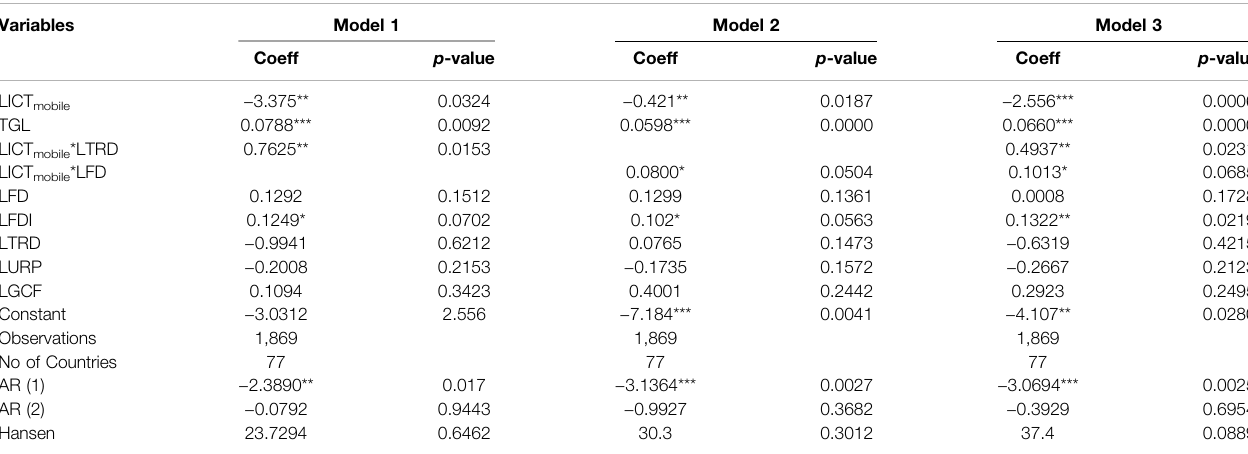
TABLE 6 | Dynamic elasticity evidence (estimation of moderating